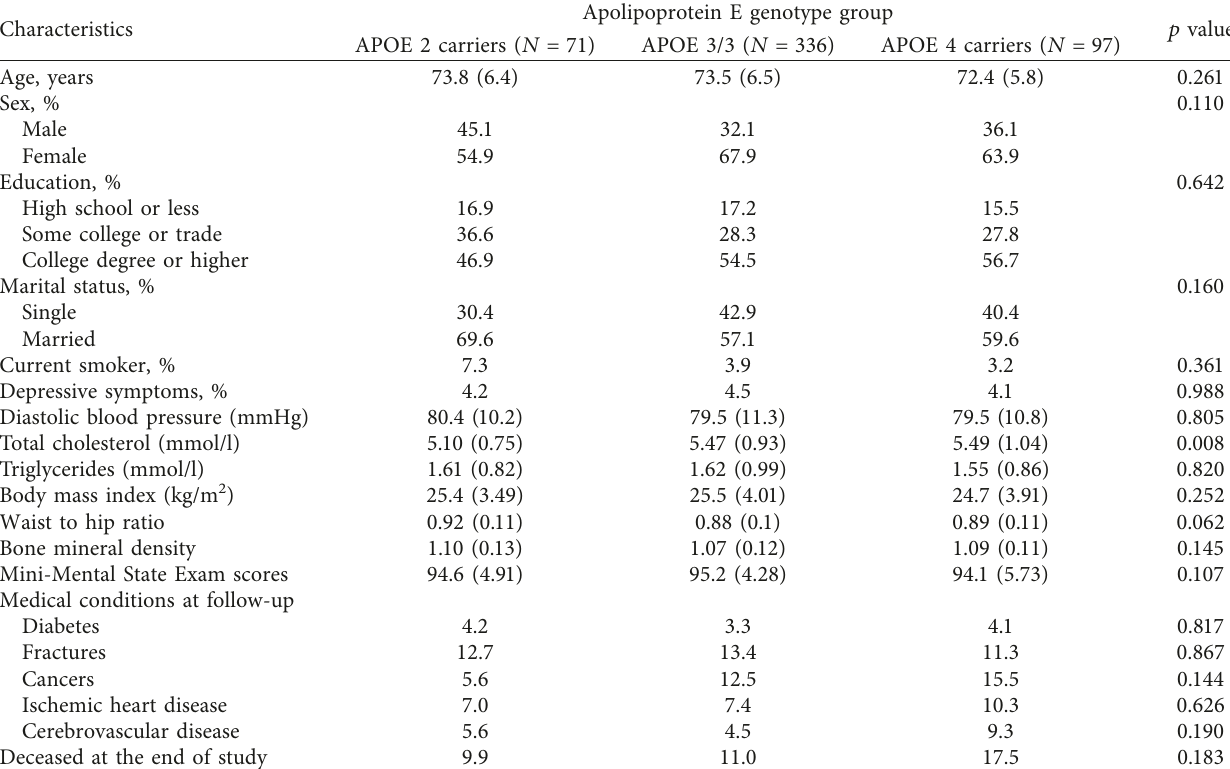
Table 1: Baseline characteristics of participants in the New Mexico Aging Process